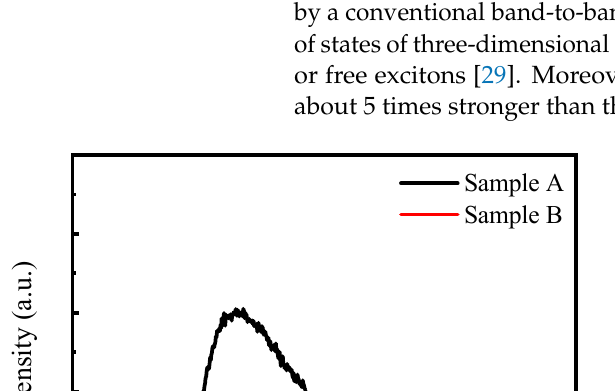
( b ) Figure 5. ( a ) PL spectra of extended wavelength InGaAs on InP substrate measured at 10 K (smoothed): ( a ) sample A and ( b ) sample B (the inset is Gaussian decomposition of PL spectrum at 95 mW). Figure 6a presents PL spectra measured at room temperature for sample A and sam- ple B, and the peak wavelength is 2297 nm and 2302 nm, respectively. An asymmetric line shape with a long high-energy tail and relatively faster declining low-energy edge is dis-